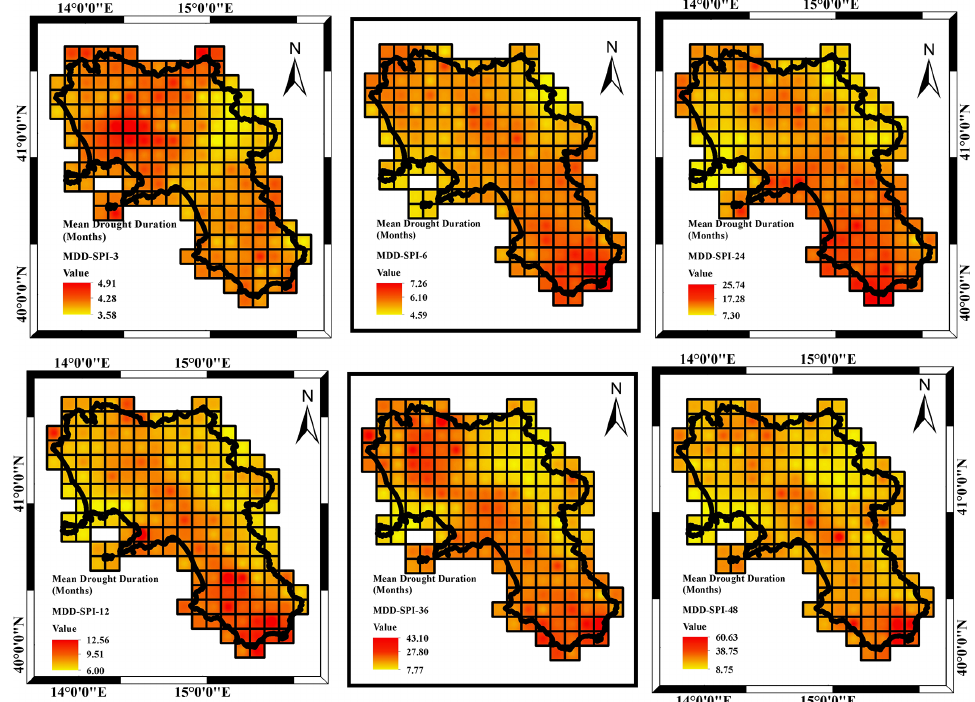
Figure 8. MDD (mean drought duration) for the different accumulation periods considered (SPI ≤ − 1).